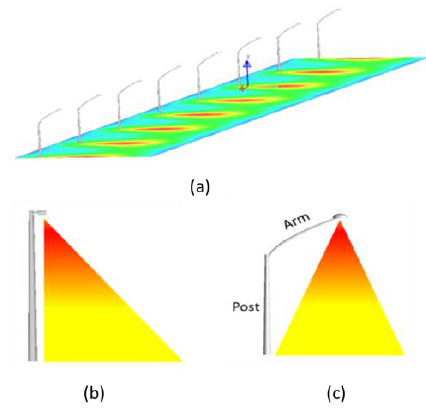
Figure 15. ( a ) Visual image of street lighting; ( b ) our proposed street lamp; ( c ) a conventional street lamp.